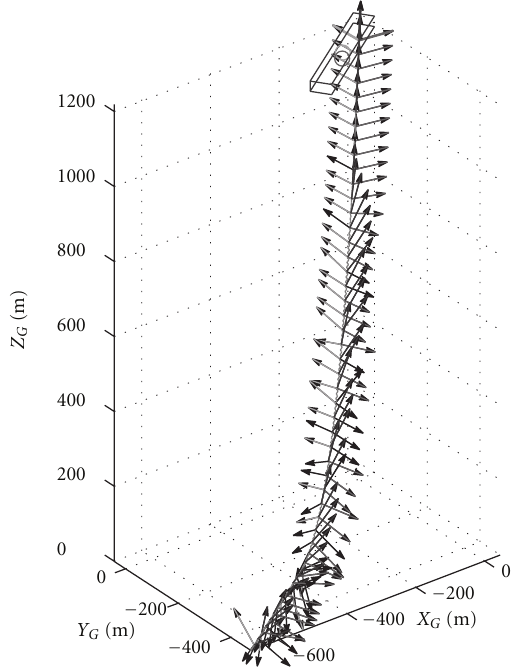
Figure 14: Robot attitude profile in the dynamic condition, including wave and VIV e ff ects. Only 1/150 of the 7.630 grid points are shown to keep the figure clearer.